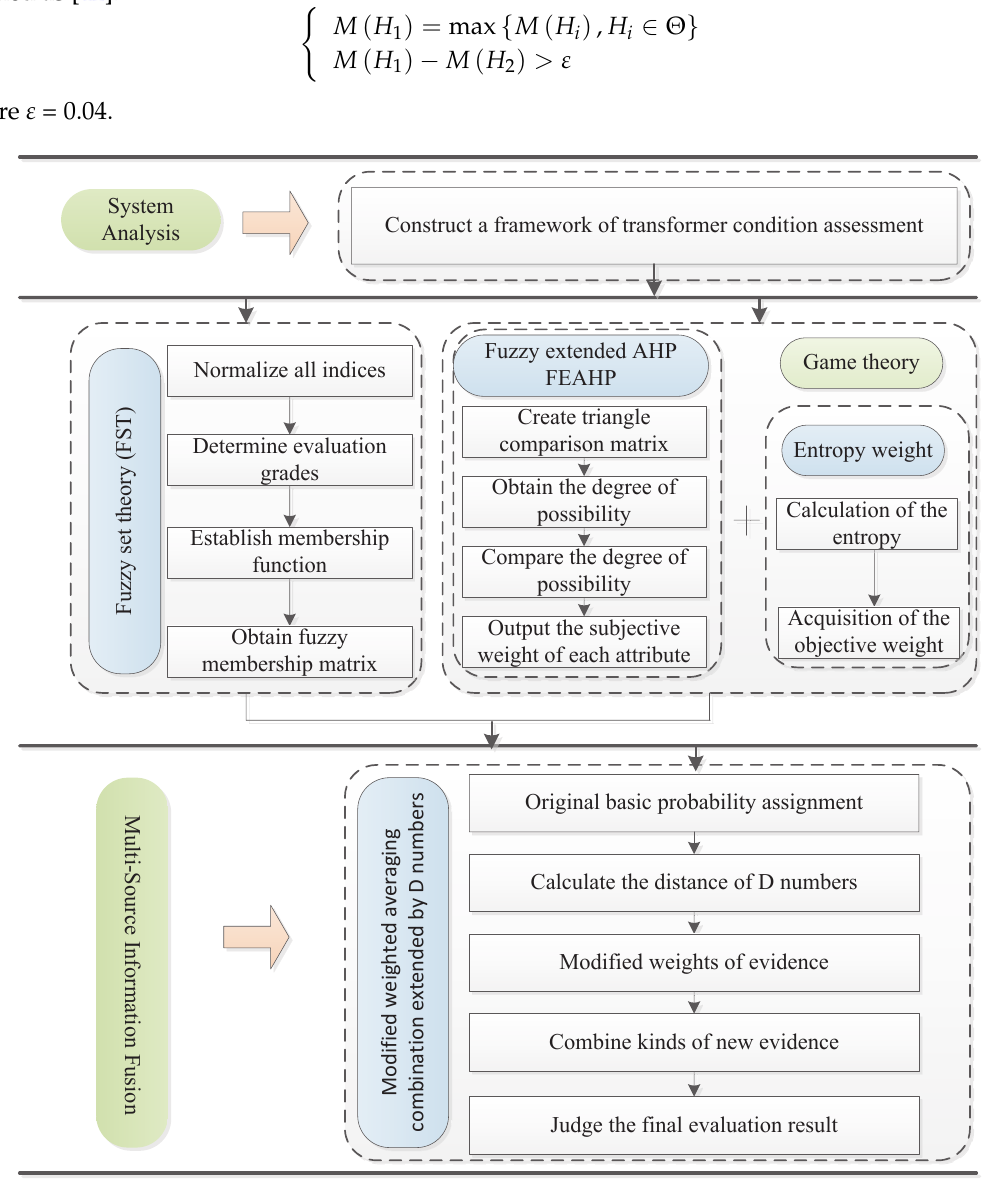
Figure 5. Flowchart of transformer condition